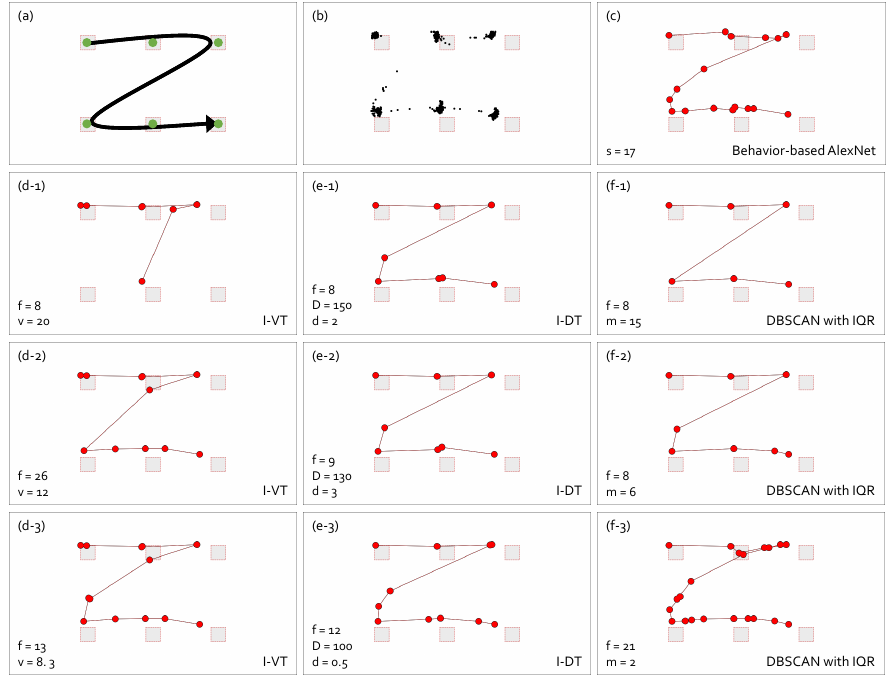
Figure 10. Comparison of scanpath visualizations with the eye movement according to the gaze- parsing algorithms. ( a ) The visual stimulus with the eye movement task of an observer. The observer pauses for 3 s at the points where the green dots are drawn during the eye movement. ( b ) The raw gaze points. ( c ) The scanpath visualization with the behavior-based gaze data processing method using AlexNet. The scanpath visualizations with I-VT in ( d-1 – d-3 ), I-DT in ( e-1 – e-3 ), and DBSCAN with IQR in ( f-1 – f-3 ) are